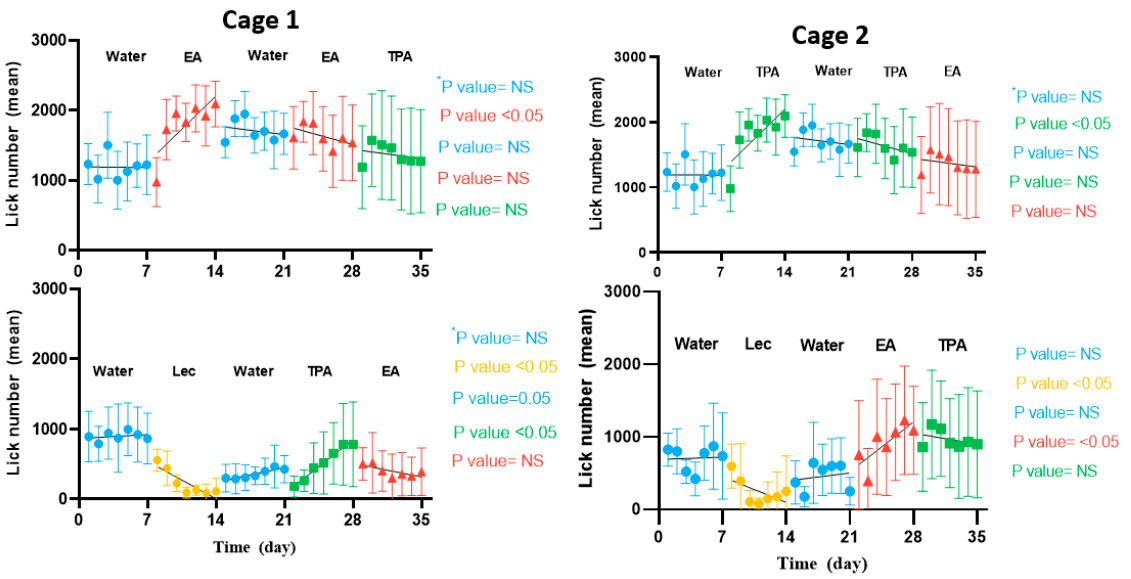
Figure 6. Changes in daily behavior of the animals during each week in both cages. Data represent means ± SD. Each bar shows the regression slope for each formulation. For each cage the box on the top represents corner 1 and 3 and the one at the bottom represents corner 2 and 4. * Significance of slope from zero.